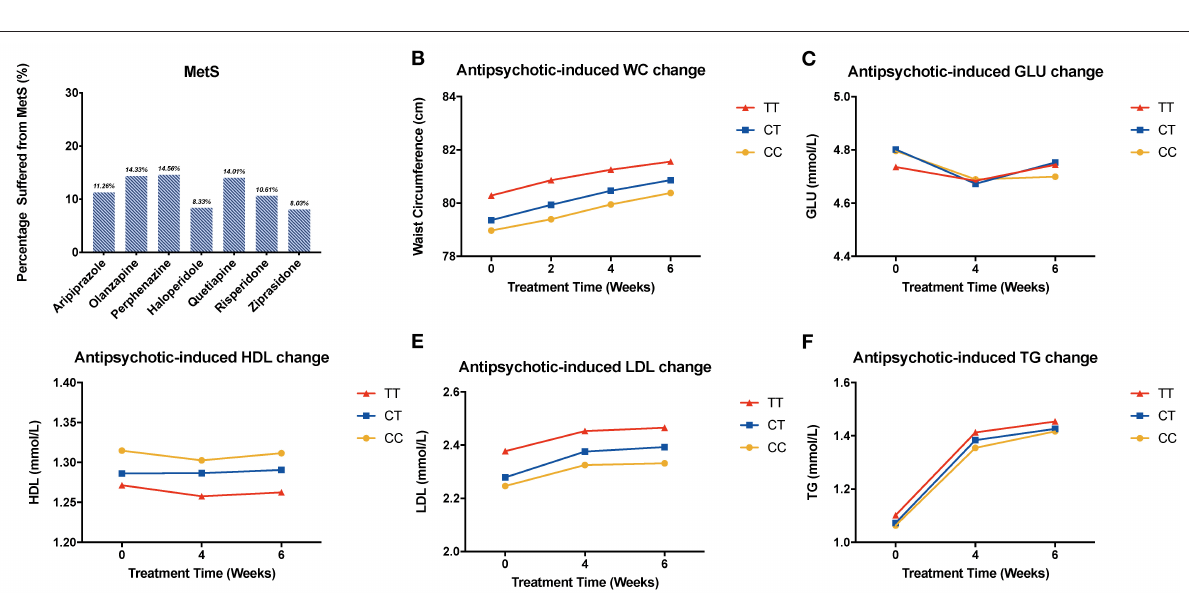
Frontiers in Psychiatry |